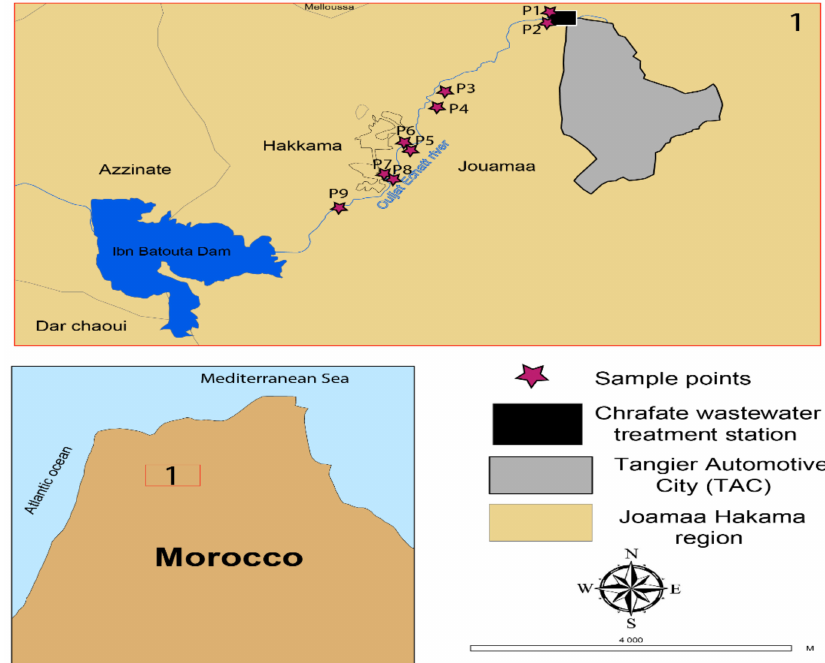
Figure 1. The study area of the Jouamaa Hakama region, northern Morocco (at the lower-right corner), with the locations of nine zone and surveying well-water sampling points, the TAC industrial zone, the Chrafate wastewater treatment station, the Ouljat Echatt river, and the Ibn Batouta dam [52].